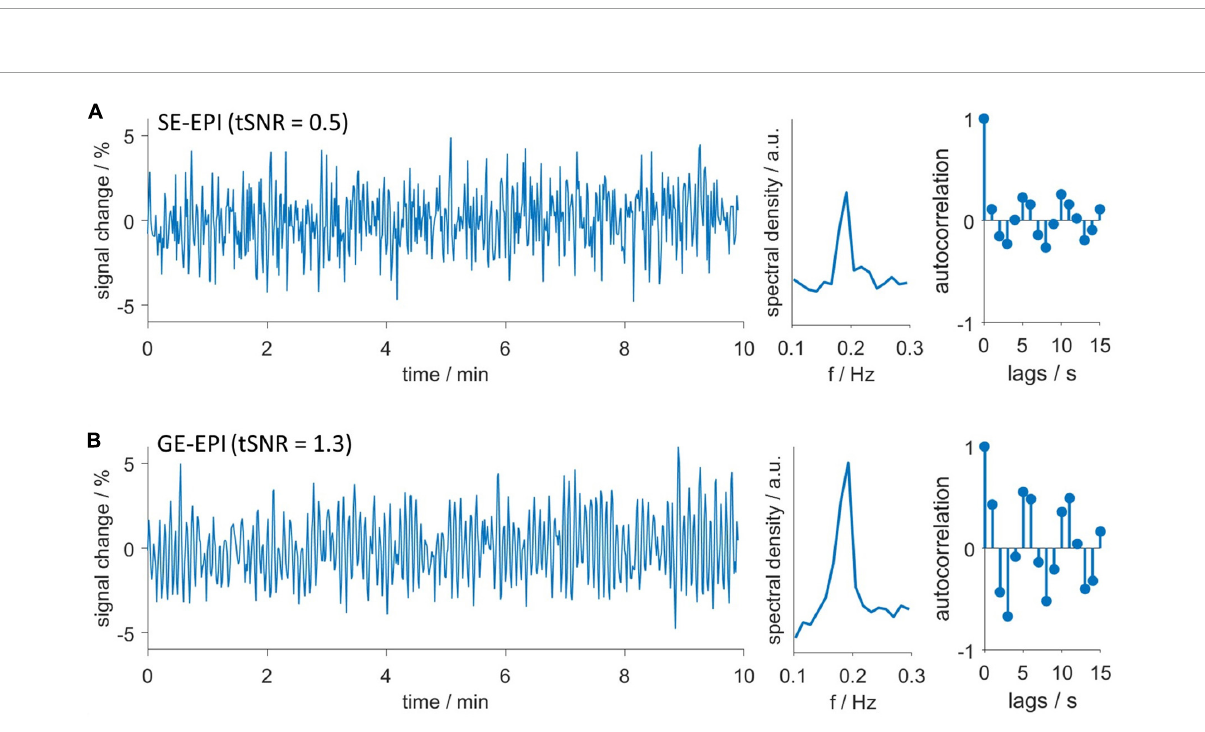
FIGURE6 Hemodynamic oscillations are detected with both GE-EPI and SE-EPI. Exemplary oscillating (A) SE-EPI and (B) GE-EPI scans. Time courses (left), spectra (middle) and autocorrelation functions (right). Both datasets were recorded in the same animal consecutively without delay. Despite lower temporal signal to noise ratio (tSNR) of SE-EPI scans, oscillations were similarly detected in both SE-EPI and GE-EPI